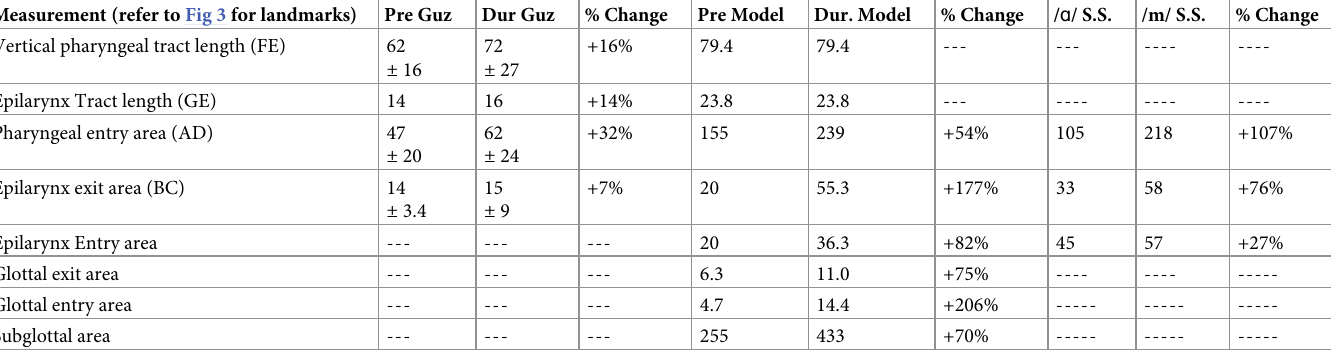
Table 1. Anatomical distances (mm) and cross-sectional areas (mm 2 ) obtained from CT scans of 10 subjects by Guzman et al., (Guz), the airway simulation model (Model), and MRI scans from a single male subject (S.S.) pre and during semi-occlusion